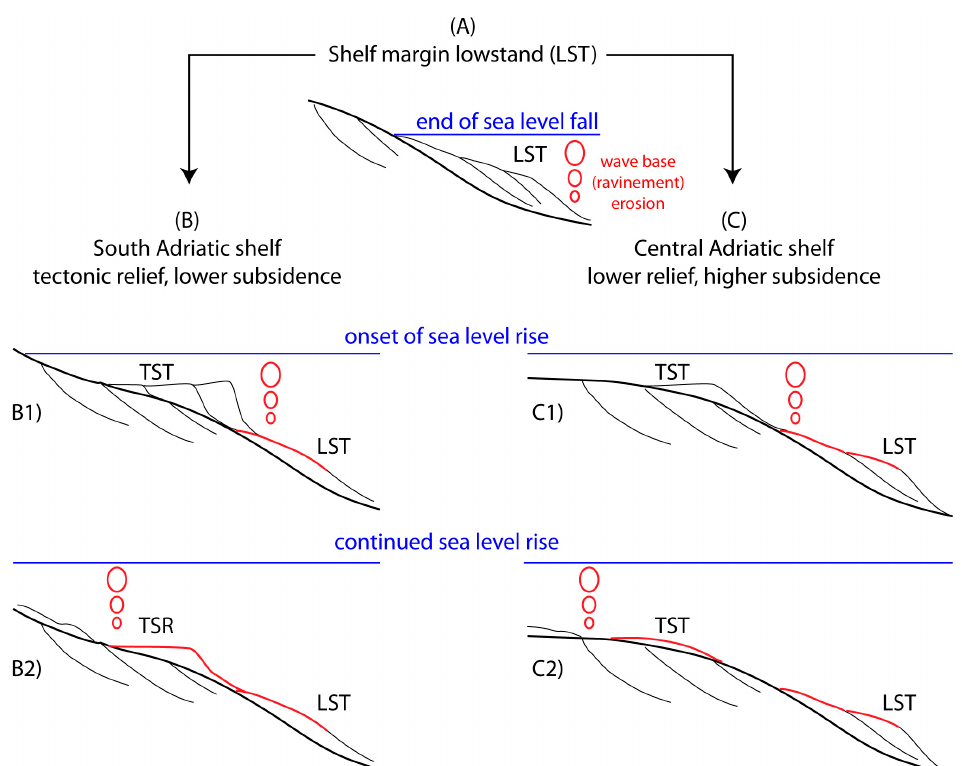
Figure 12. Simplified scheme representing differential deposition and preservation of the TSR deposits. Lowstand (LST) near-shore deposits ( A ) are differently reworked during transgression on the tectonically uplifted South Adriatic ( B ) and subsiding Central Adriatic margin ( C ). At the onset of sea level rise, LST deposits are more intensely eroded and reworked into early TST deposits in the South Adriatic, where higher gradients/relief enhance ravinement erosion and hamper rapid flooding of LST below wave base erosion ( B1 ). On the subsiding Central Adriatic shelf margin, lower shelf gradients/relief enhance drowning and allow LST deposits to partly escape erosional reworking during transgression. This determines a reduced availability of coarse sediment, in turn resulting in a less developed early TST near-shore deposit ( C1 ). As sea level rise continues, the early TST deposits also undergo transgressive (ravinement) erosion ( B2 , C2 ); however, only in the South Adriatic do the thicker units escape complete erosion and preserve their wedged shape, forming the shelf edge TSR ( B2 ).